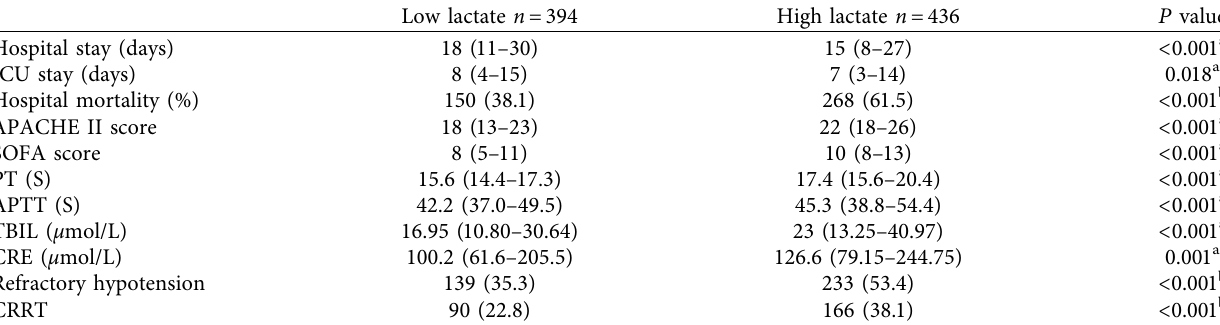
Table 5: Organ dysfunction and clinical outcome comparison of patients in the high lactate group and the low lactate group.